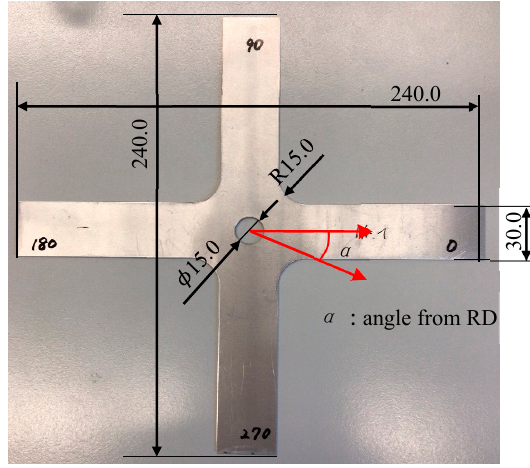
Figure 15. Biaxial tensile testing machine.